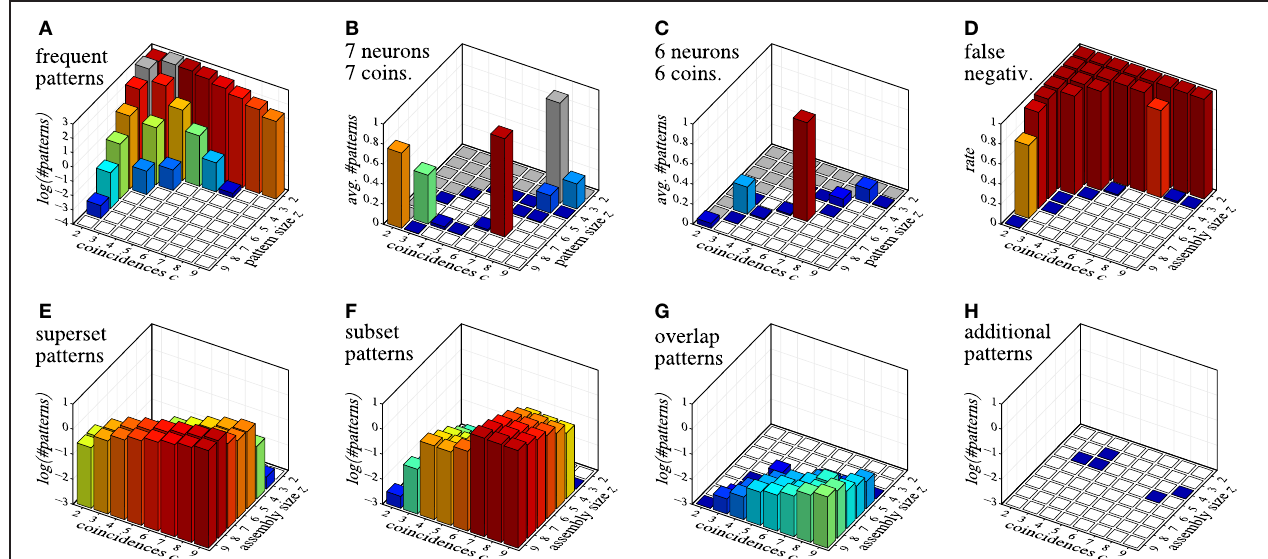
FIGURE 10 | Assembly detection with surrogate data filtering based on size/coincidence signatures (cid:2) z , c (cid:3) . (A) decimal logarithm of the average number of patterns found in 10,000 surrogate data sets; (B and C) average numbers of patterns detected in 1000 data sets with injected assemblies with (cid:9) z , c (cid:10) = (cid:9) 7 , 7 (cid:10) and (cid:9) z , c (cid:10) = (cid:9) 6 , 6 (cid:10) , respectively (gray squares indicate signatures that occur in the surrogates and are therefore eliminated); (D) false negatives for